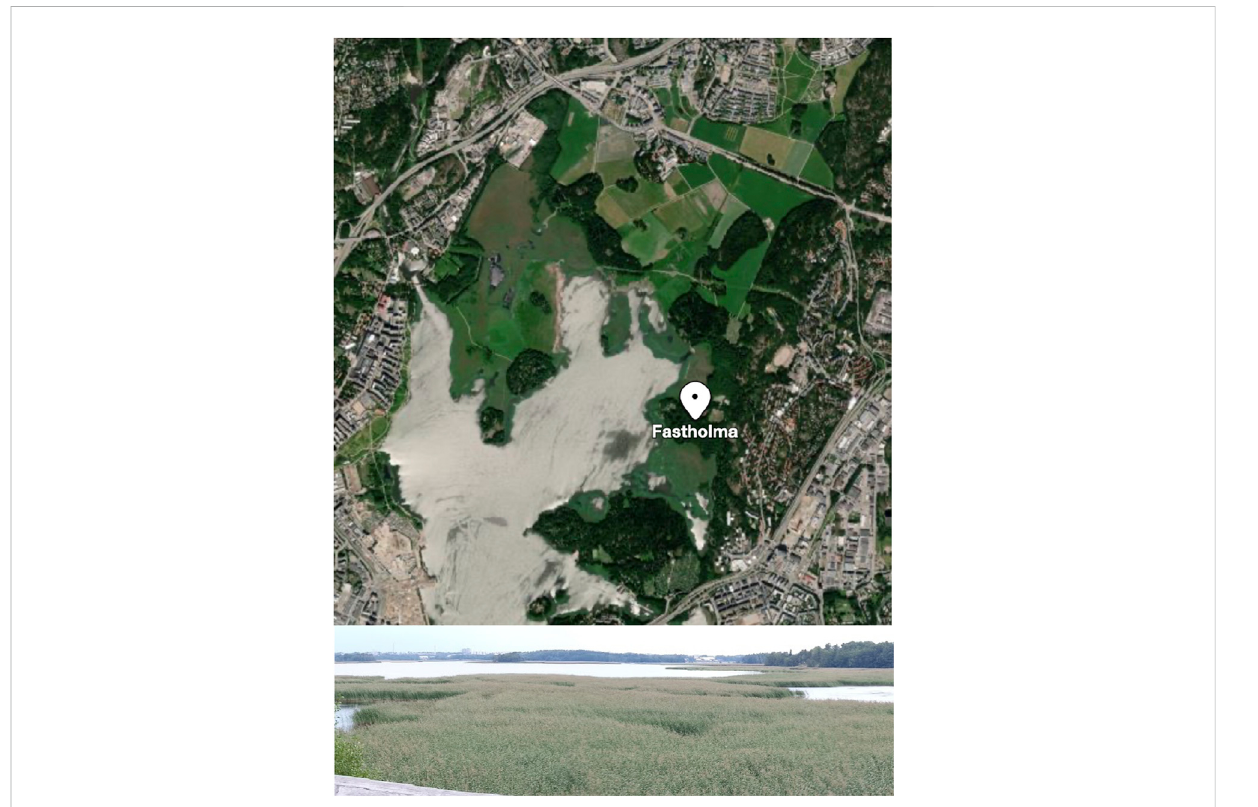
FIGURE 13 Multi-affordance greenspace characteristics. Fastholma Greenspace. Orthophoto Top — BingMaps (2022). Perspective bottom — GoogleEarth StreetView